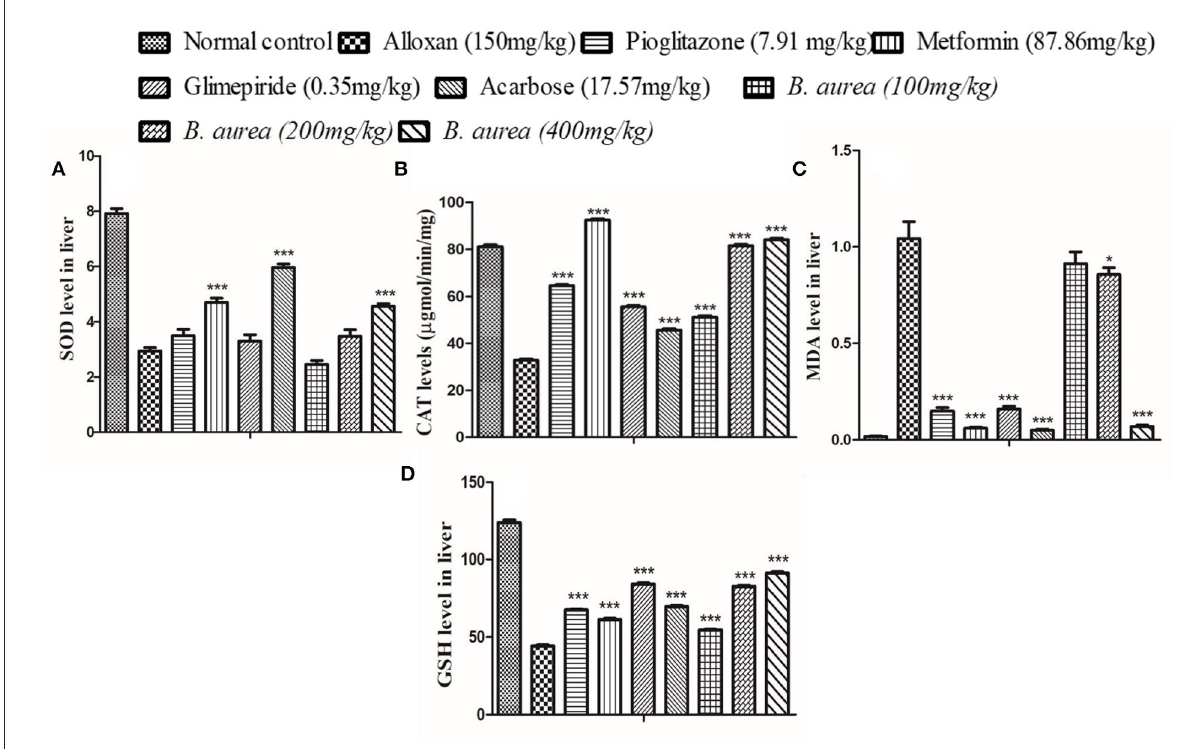
FIGURE7 Effect of B. aurea on antioxidant enzyme level in the liver of diabetic animals. (A) superoxide dismutase (SOD), (B) catalase (CAT), (C) melanoaldehyde (MDA), and (D) reduced Glutathione (GSH). *** p < 0.001, ** p < 0.01, * p < 0.05 significant values.